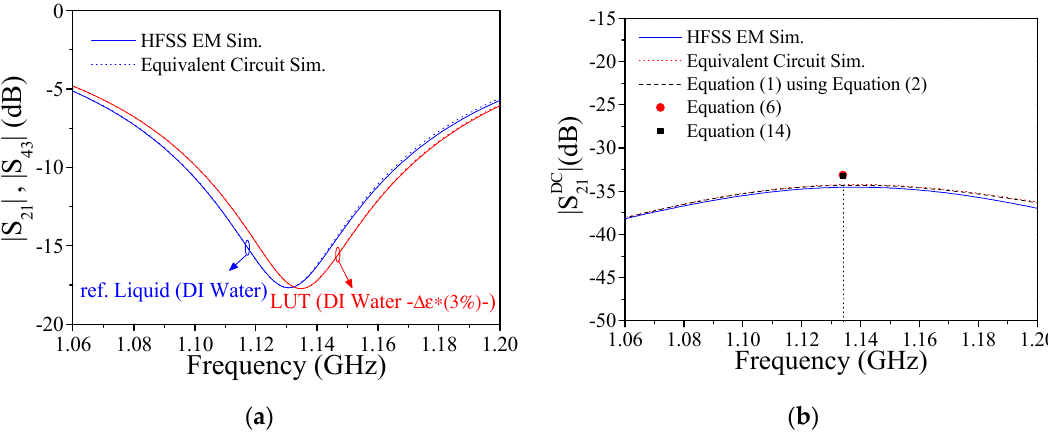
Figure 5. ( a ) Simulated frequency response for the magnitude of the transmission coefficients considering deionized (DI) water in the reference (REF) channel and 3% perturbed DI water in the liquid under test (LUT) channel; ( b ) magnitude of the cross-mode transmission coefficient considering the presented equivalent circuit model, the HFSS electromagnetic (EM) simulations, and Equations (6) and (14).